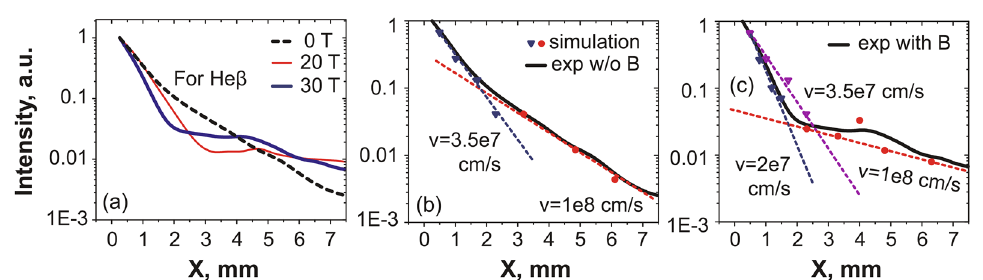
Figure 7. Scheme of the mechanisms producing the populations implied in the generation of the spectral resonance lines of multicharged ions. Here are depicted the levels with charges Z in its ground states; levels 1 and 2 are excited levels. The red and blue lines correspond to the excitation or recombination population mechanism into the excited level. The further transition of an electron from each excited state (black arrows) leads to the ion emission of the corresponding spectral line.